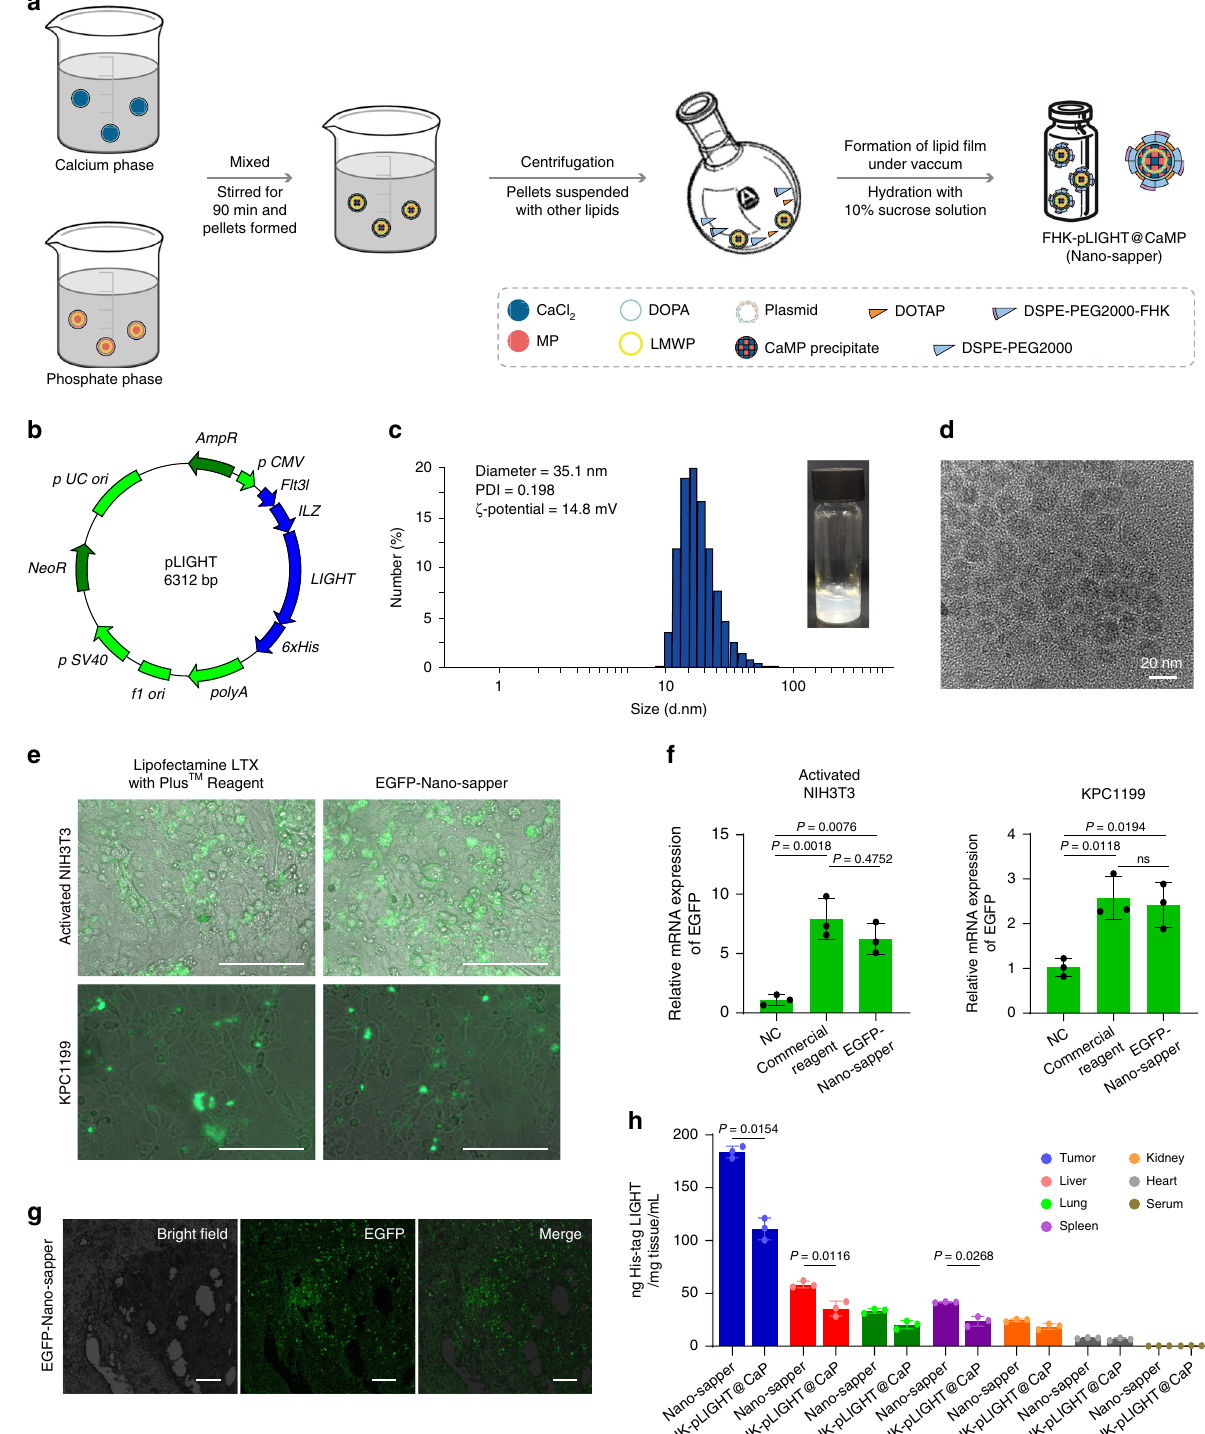
the same process except the variation in core components. For pLIGHT, the coding sequences of the extracellular domain of LIGHT (59-239 aa) and the C-terminal trimerization domain were incorporated to assemble LIGHT plasmid (Fig. 2b). The diameter of Nano-sapper was ~35 nm or 20 nm as determined by dynamic light scattering (DLS) analysis or transmission electron microscopy (TEM) (Fig. 2c, d and Supplementary Table 1). The surface charge of Nano-sapper was around 15 mV. The